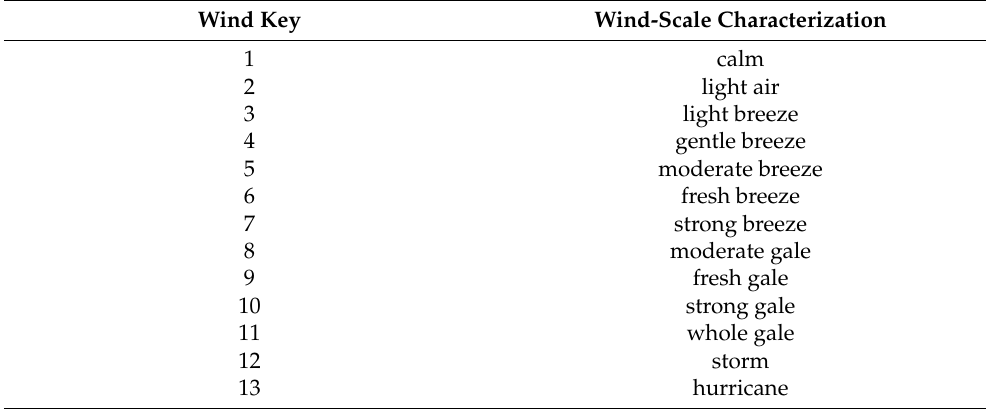
Table 1. Wind types.